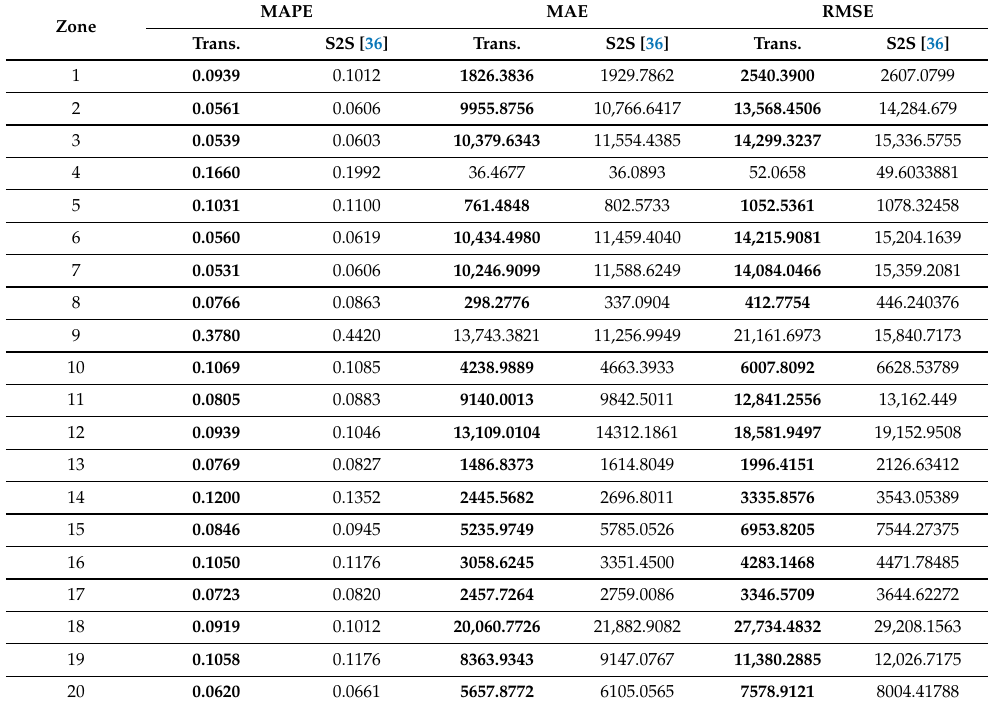
Table 4. Accuracy comparison of S2S and Transformer for each Stream. The bold numbers indicate where transformers outperform S2S.